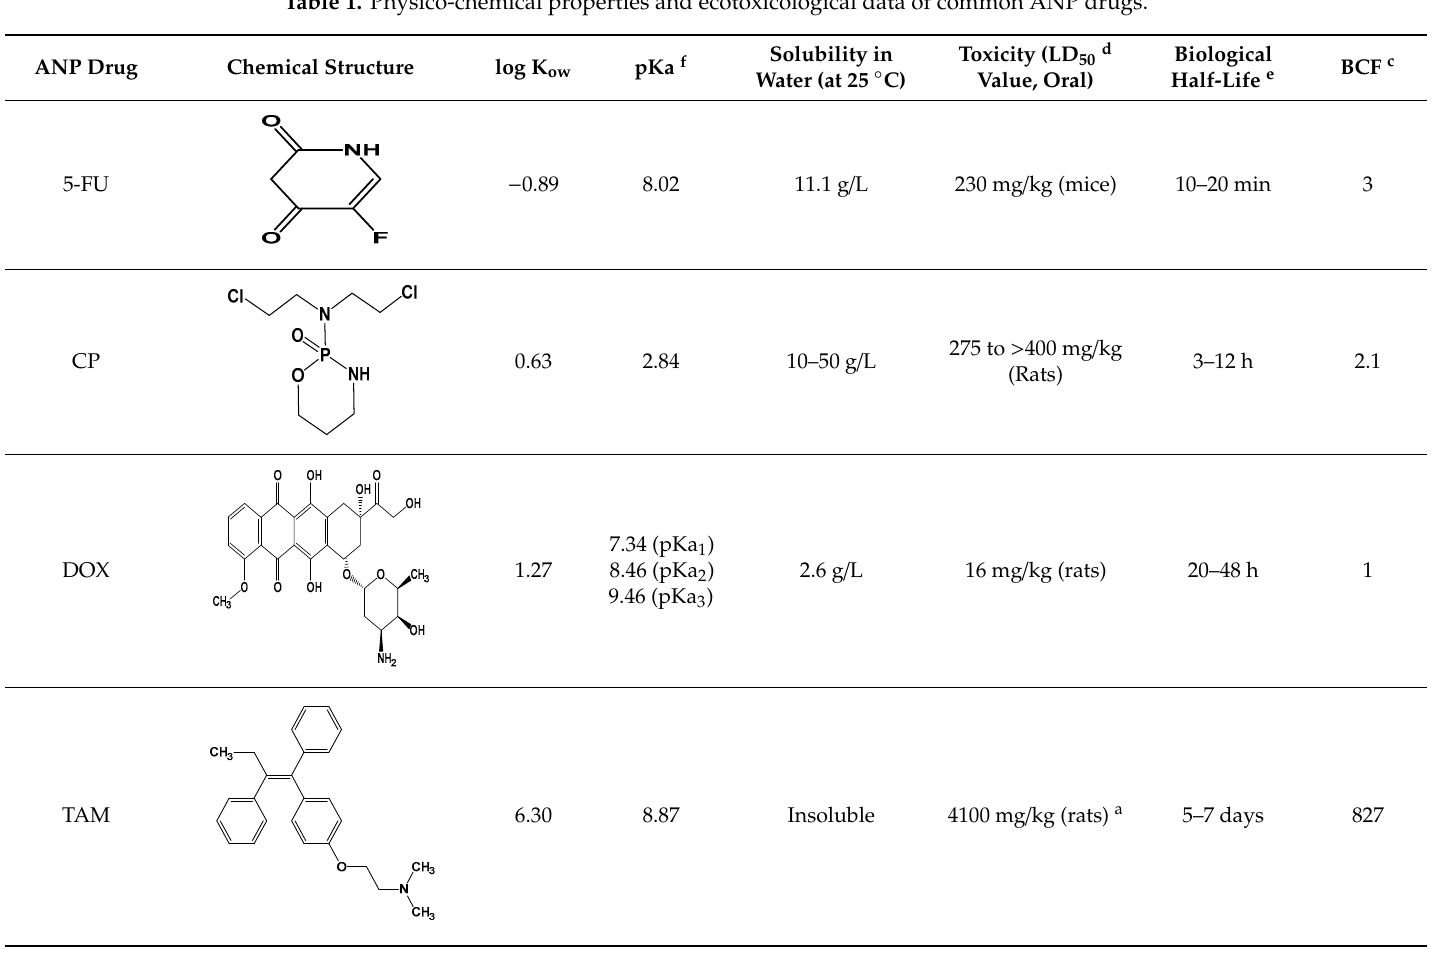
Table 1. Physico-chemical properties and ecotoxicological data of common ANP drugs.